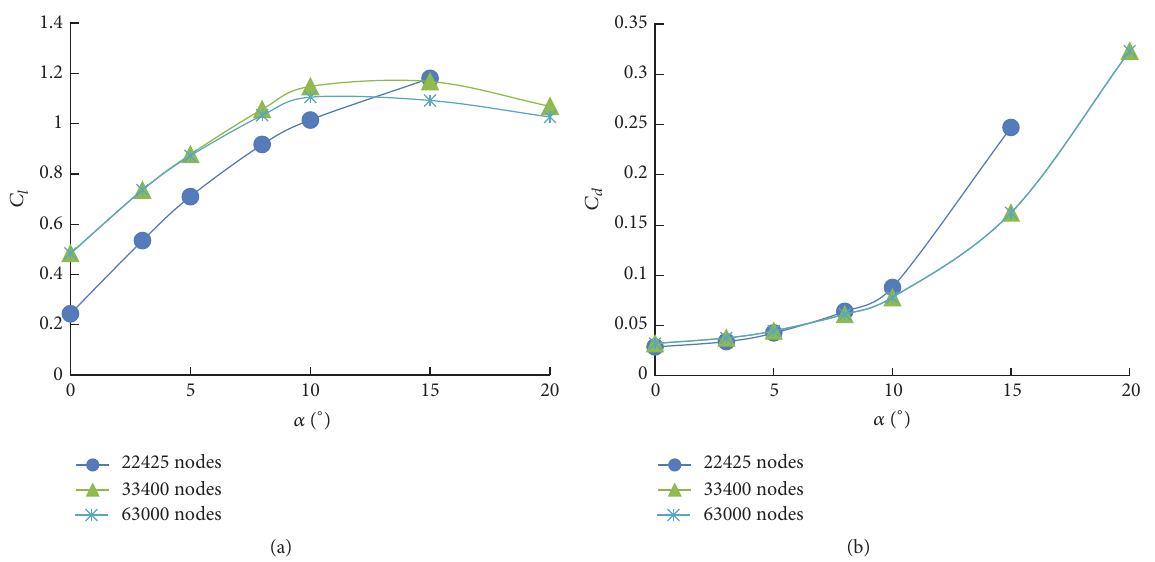
Figure 8: Comparison of simulation results of three grid resolutions of coarse (22425 nodes), medium (33400 nodes), and fine (63000 nodes) meshes at Re = 6 × 10 4 . (a) Lift coefficients ( 𝐶 𝑙 ) and (b) drag coefficients ( 𝐶 𝑑 ).